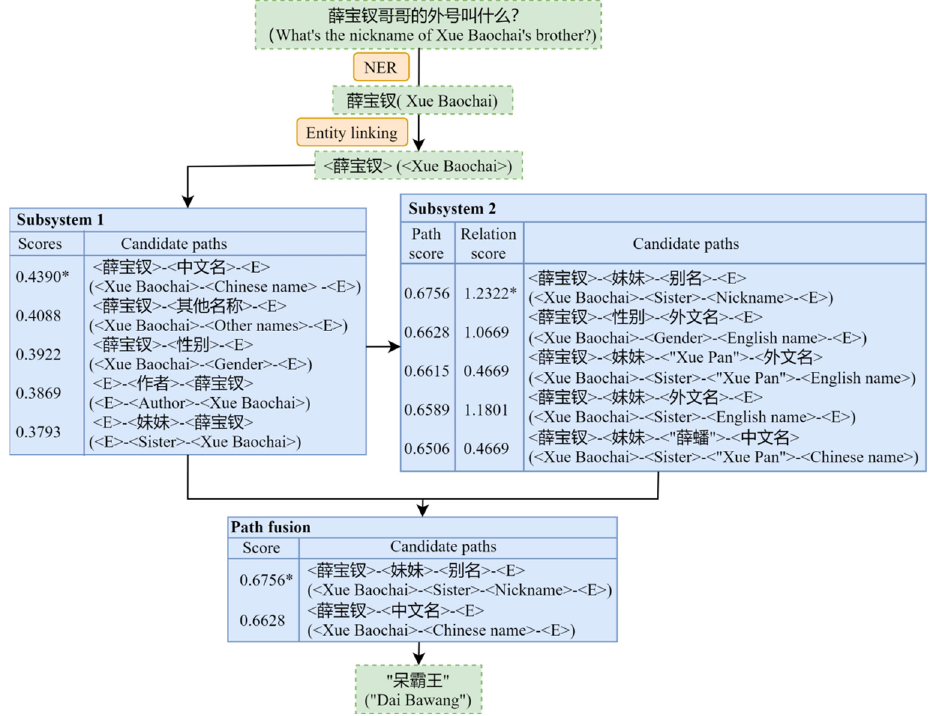
Figure 9. The workflow of the joint system.